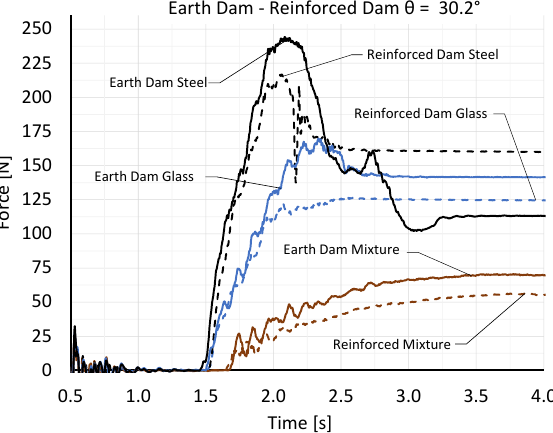
Figure 12. Force–time history comparison between an earth dam and a geogrid-reinforced dam for an inclination of the flume base of θ = 30.2°.